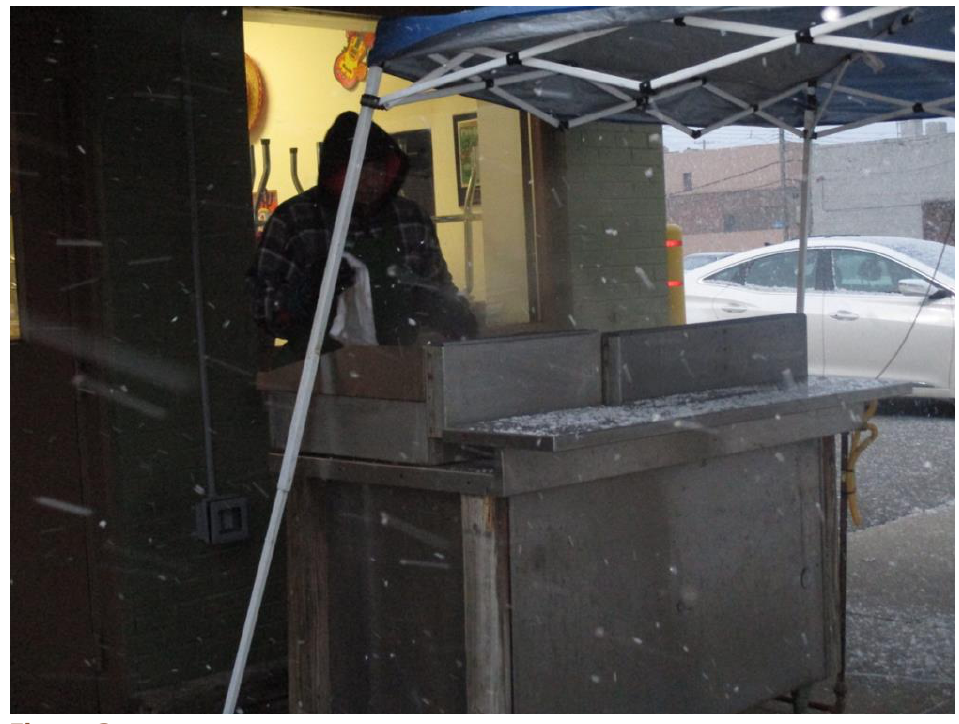
Teresa García, Selling Tacos Under the Harsh Winter , Digital photograph, Pittsburgh, PA, December 5, 2016. Courtesy of Héctor Camilo Ruiz